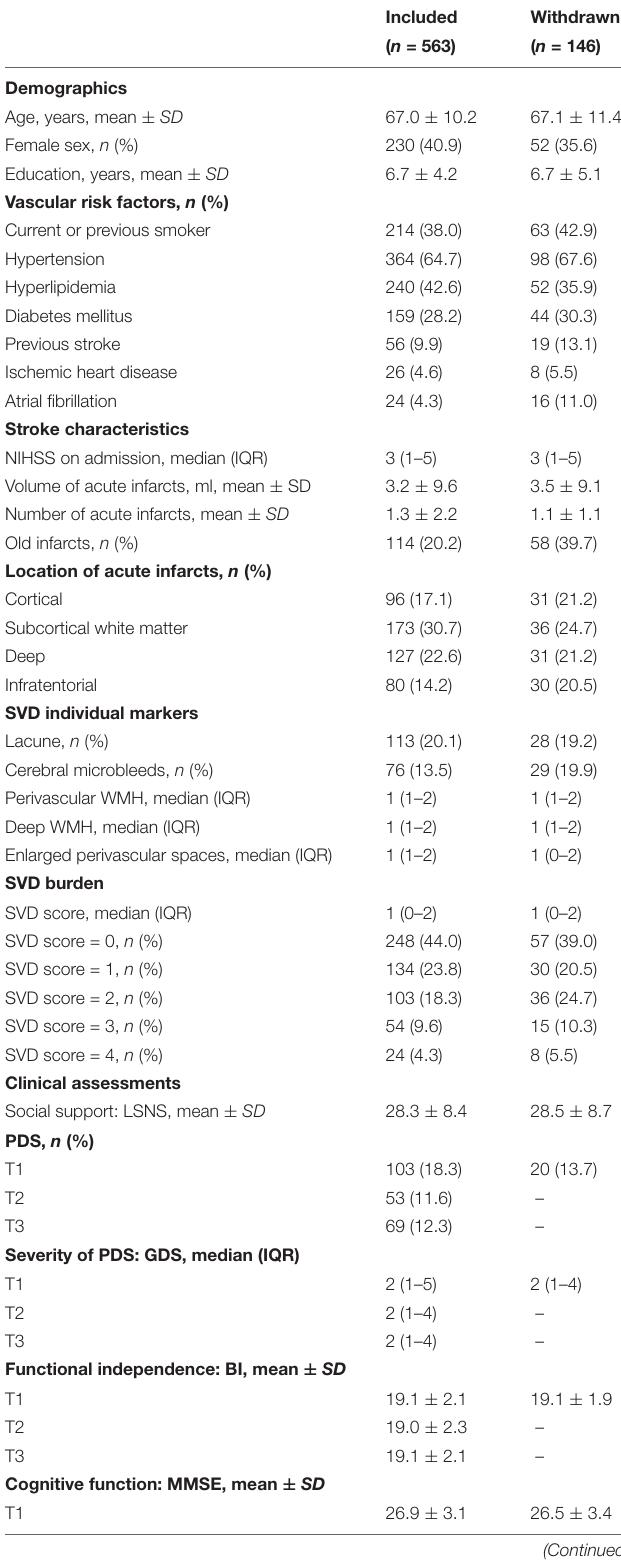
TABLE 1 | Comparison of demographic, clinical and MRI characteristics between the study sample and the patients withdrawn from the study.